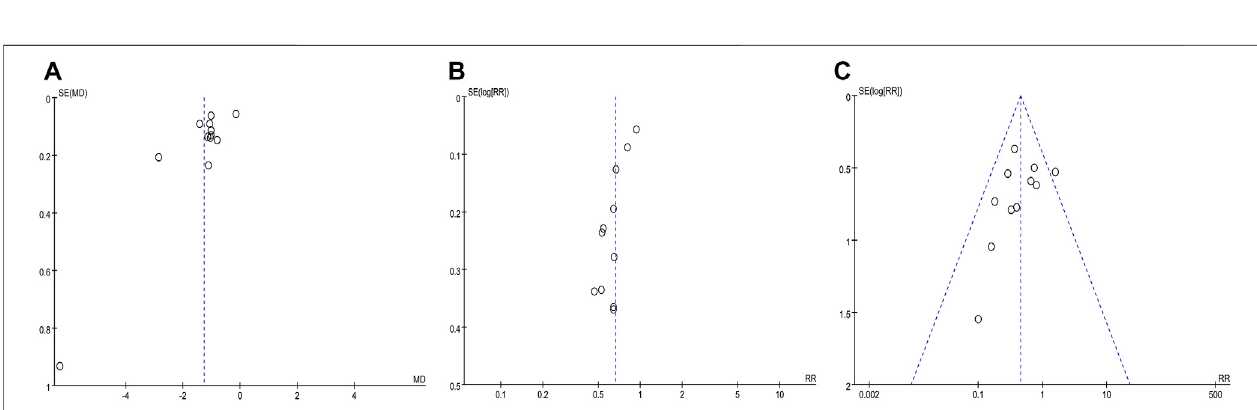
FIGURE10 | Funnel plot ofthe comparison between CHM combinedwithAEDsand AEDs alone for monthly seizure frequency (A) , abnormal rateof EEG (B) , and adverse events (C) .